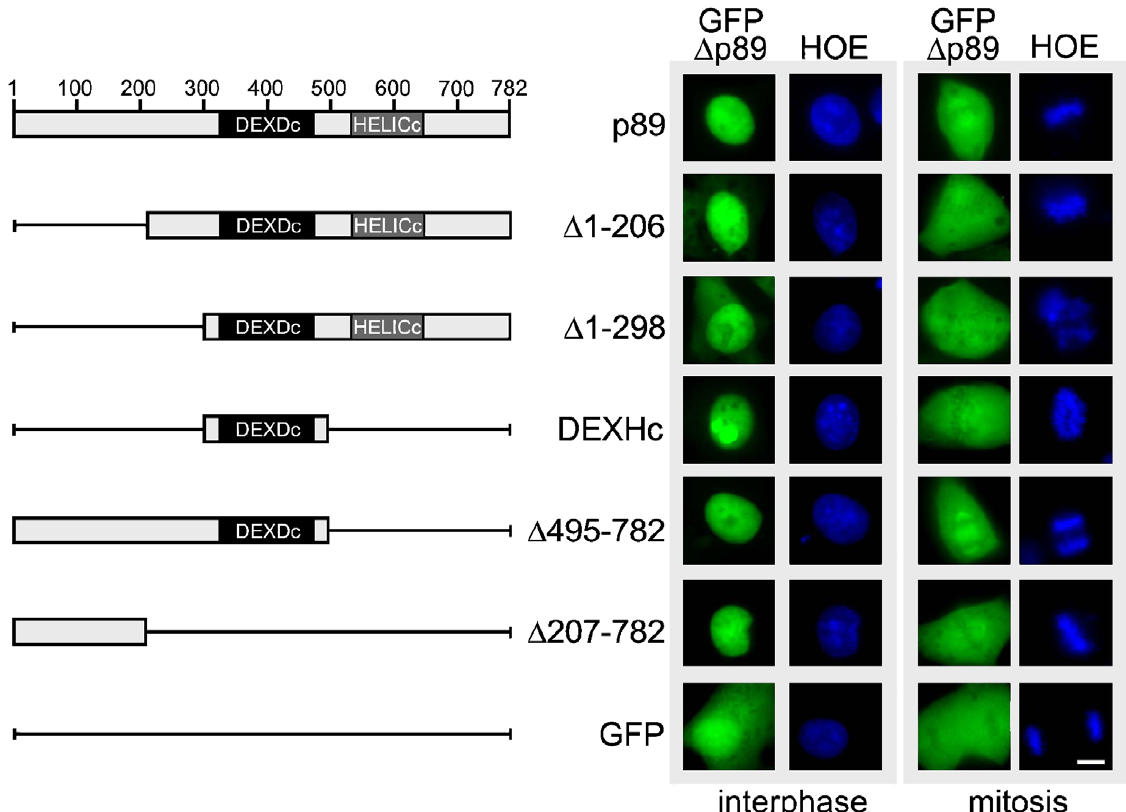
Fig. 5. Truncations of p89 affect its subcellular localization. (A) Deletions were generated by truncating part of the N-terminus ( Δ 1-206, Δ 1-298), the N- and C-terminus, and the C-terminus with loss of HELICc only ( Δ 495-782), or HELICc and DEXDc ( Δ 207-782). (B) Deletions of N-terminal parts of p89 interfere with the nearly exclusive nuclear localization during interphase. Deletions of C-terminal parts of p89 hardly in- terfere with the nearly exclusive nuclear localization. Truncation of the N-terminus significantly reduces mitotic association with the centrosome, whereas C-terminal deletion is interfering less with centrosomal localization ( Δ 495-782). Deleting both, large parts of the N- and C-terminus of p89, not only reduces proper distribution, but also leads to toxic accumulation within the nucleus (DEXDc). GFP-p89 (top row) and GFP-mock (bottom row) are shown for comparison. Scale bar = 10